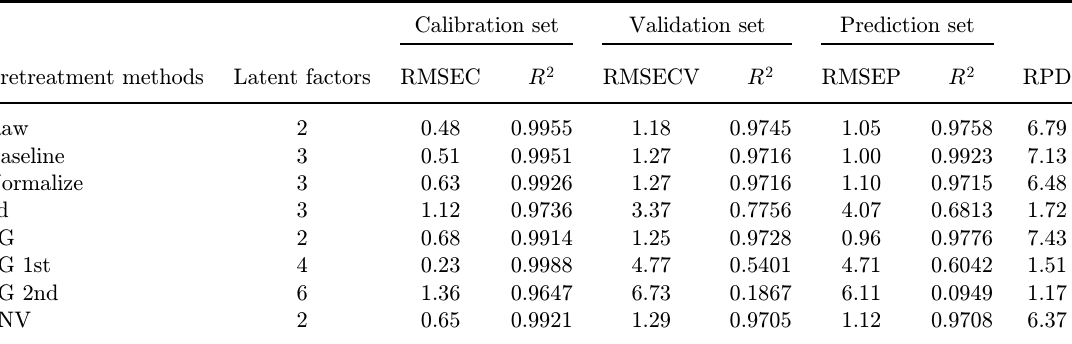
Table 1. Di®erent pretreatment methods of PLS